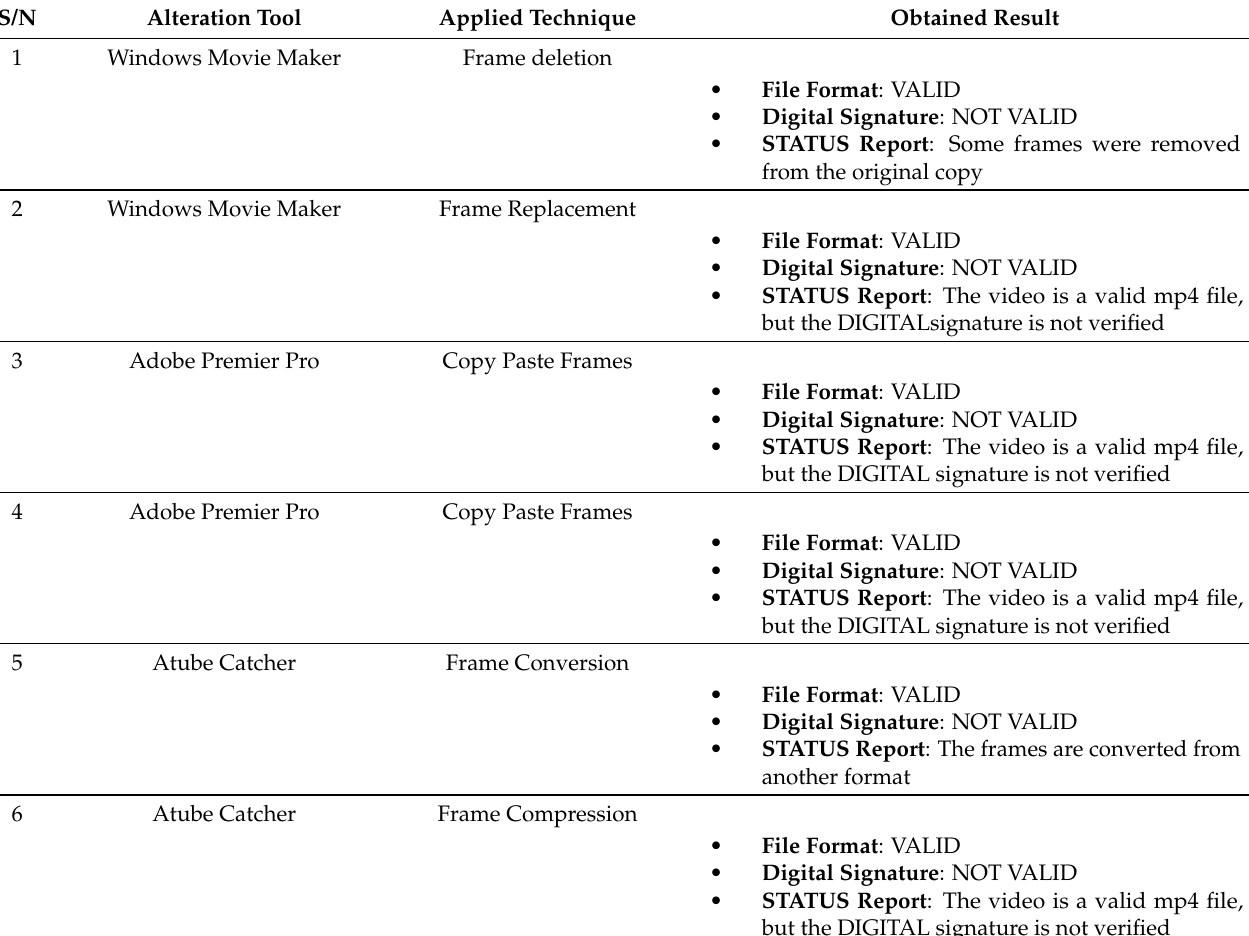
Table 7. Tool validation using off-the-shelf file alteration